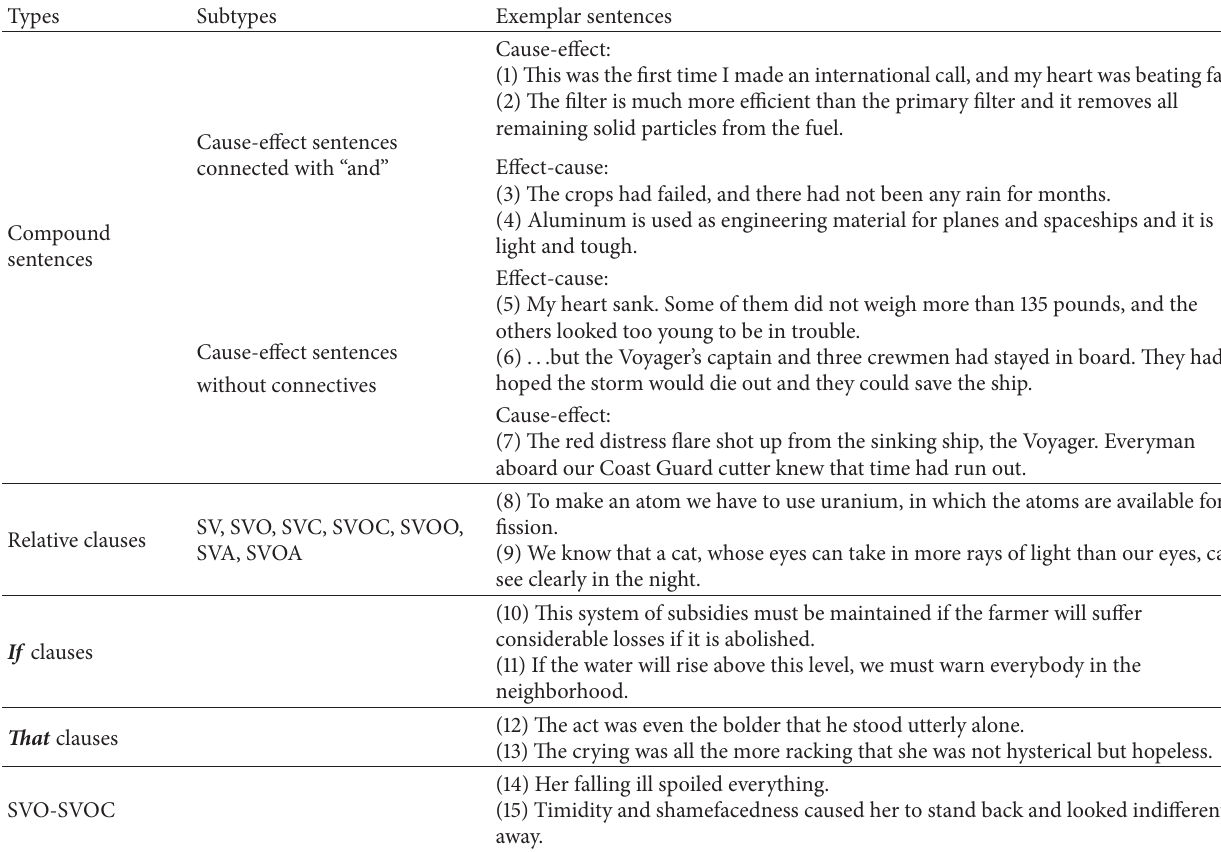
Table 2: Types of implicit causality